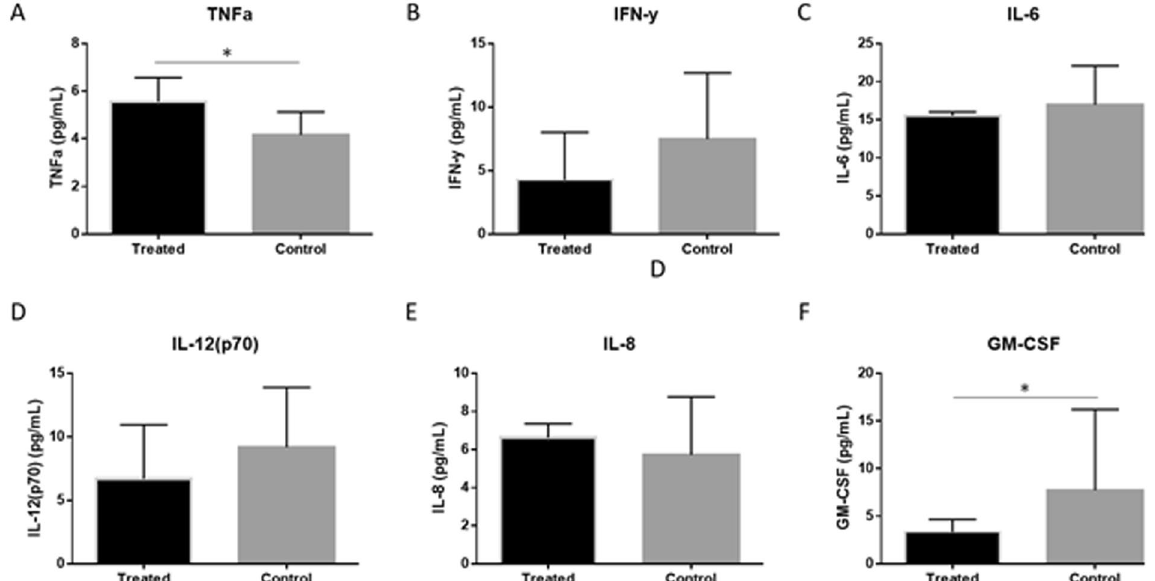
Figure 7. TTP knockdown results in higher levels of TNF- α cytokine: In vitro downstream protein analysis of inflammatory cytokines associated with RNA binding protein regulation in TTP knockdown EECCs. Although mRNA transcripts of TNF- α was significantly higher in control EECCs compared to TTP knockdown cells, the opposite was observed at the protein level using multiplexing (Panel A). Other inflammatory cytokines for IFN- γ , IL-6, IL-12(p70), IL-8 and GM-CSF did not differ at protein level (Panels B–F). Expression data illustrated as mean ± SEM. * P < 0.05. Data is derived from three independent experiments; n = 3.